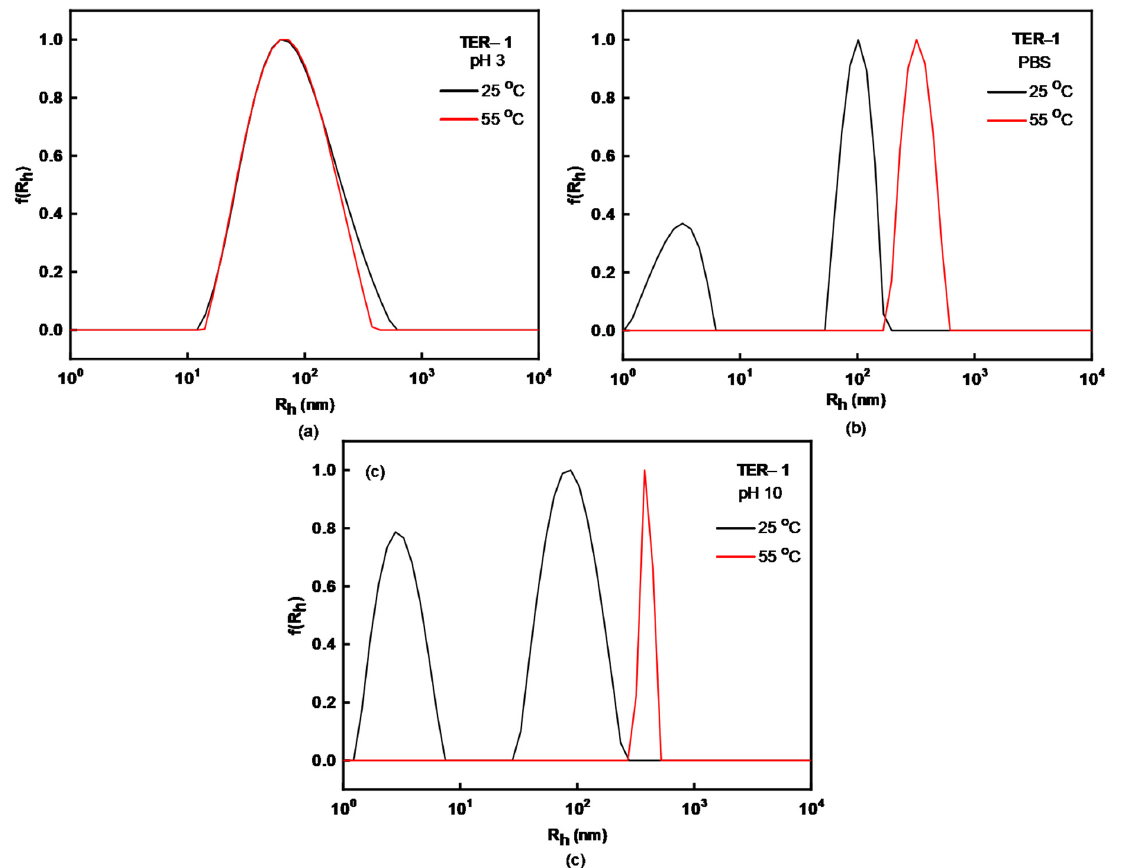
Figure 4. CONTIN size distributions for TER-1 terpolymer at ( a ) pH = 3, ( b ) PBS and ( c ) pH = 10, as a function of temperature.